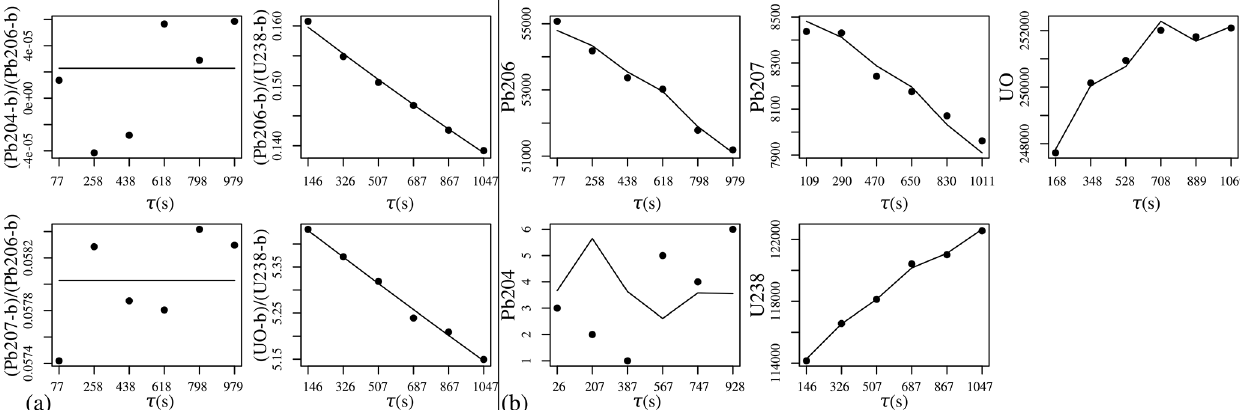
Figure 5. (a) Background- and drift-corrected ratio fits to the SHRIMP data from Fig. 3, obtained using the generalised linear model of Eq. (19). The slope parameter ( γ Y in Eq. 19) is zero for isotopes of the same element and non-zero for isotopes of different elements. X Vertical axes are unitless. (b) The four (log-)ratio fits can be converted back to five isotope signal fits using the inverse log-ratio transforma- tion. Multiplying the normalised ion beam intensity fits with the total number of counts per sweep allows direct comparison with the raw measurements, which are shown as filled circles. Vertical axes have units of counts. Note that the measurements have Poisson uncertainties, which scale with the square root of the values.